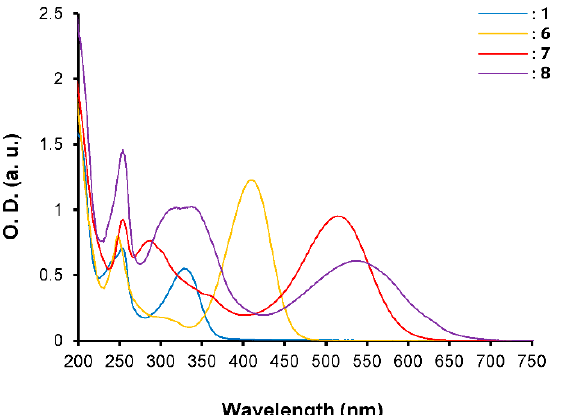
× 10 − 5 3 CN at [C] = ca 1.40